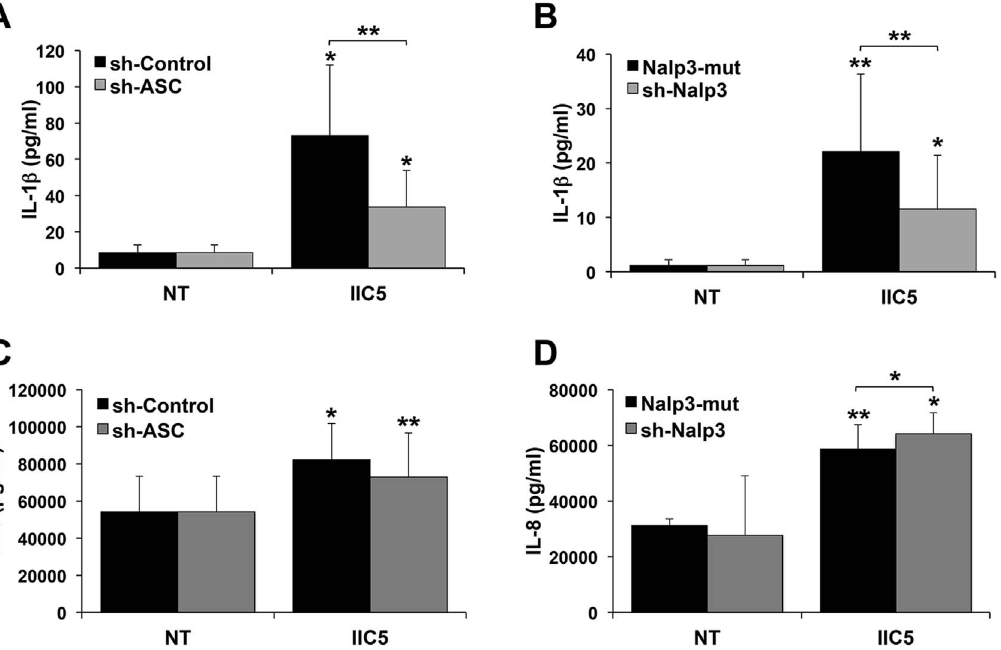
Figure 3. Antiphospholipid antibody-induced trophoblast IL-1 b is dependent on ASC and Nalp3. Trophoblast transfected to express either (A & C) shRNA for ASC (sh-ASC) or a control sequence (sh-control) (n=5); or (B & D) shRNA for Nalp3 (sh-Nalp3) or a Nalp3 mutated targeting sequence (Nalp3-mut) (n=4), were either not treated (NT) or treated with the anti- b 2 GPI mAb, IIC5 (20 m g/ml) for 72 hrs. Culture supernatants were measured for (A & B) IL-1 b and (C & D) IL-8 by ELISA. * p , 0.05; ** p , 0.001 versus the NT control, unless indicated